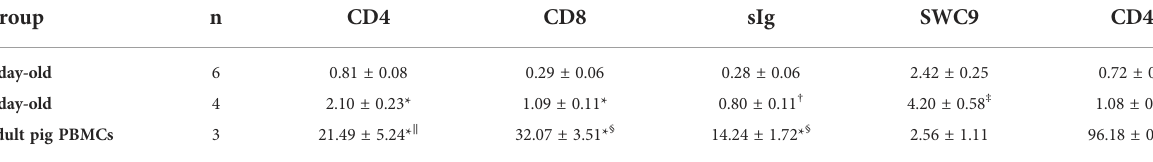
Pigisletsweredissociatedintosinglecellsfollowingourstandardprotocolasdescribed.Followingdissociation,0.5×10 6 cellswereincubatedwithantibodiestospeci fi cimmunecellmarkers. The percentage of immune cells expressing the markers was analyzed by fl ow cytometry. Adult pig PBMCs were used as a positive control. *p ≤ 0.0005 between islets from 3- vs. 7-day-old pigs or adult pig PBMCs. † p ≤ 0.005 between islets from 3- vs. 7-day-old pigs. ‡ p ≤ 0.05 between islets from 3- vs. 7-day-old pigs. § p ≤ 0.0005 islets from 7-day-old vs. adult pig PBMCs. ‖ p ≤ 0.01 islets from 7-day-old vs. adult pig